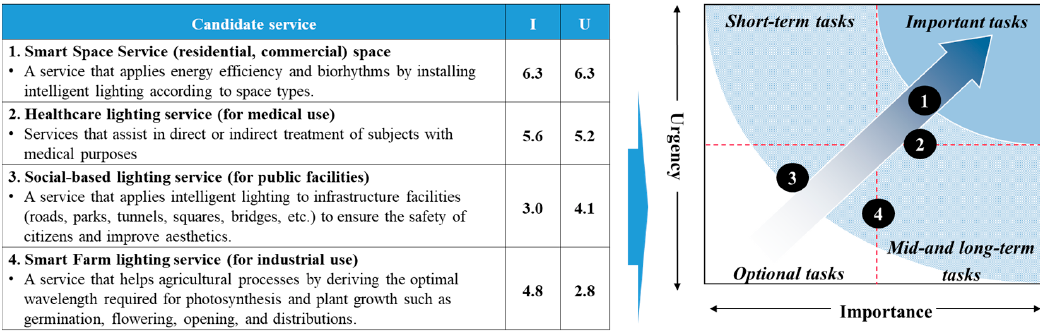
Figure 2. IPA analysis results of HCL candidate services.